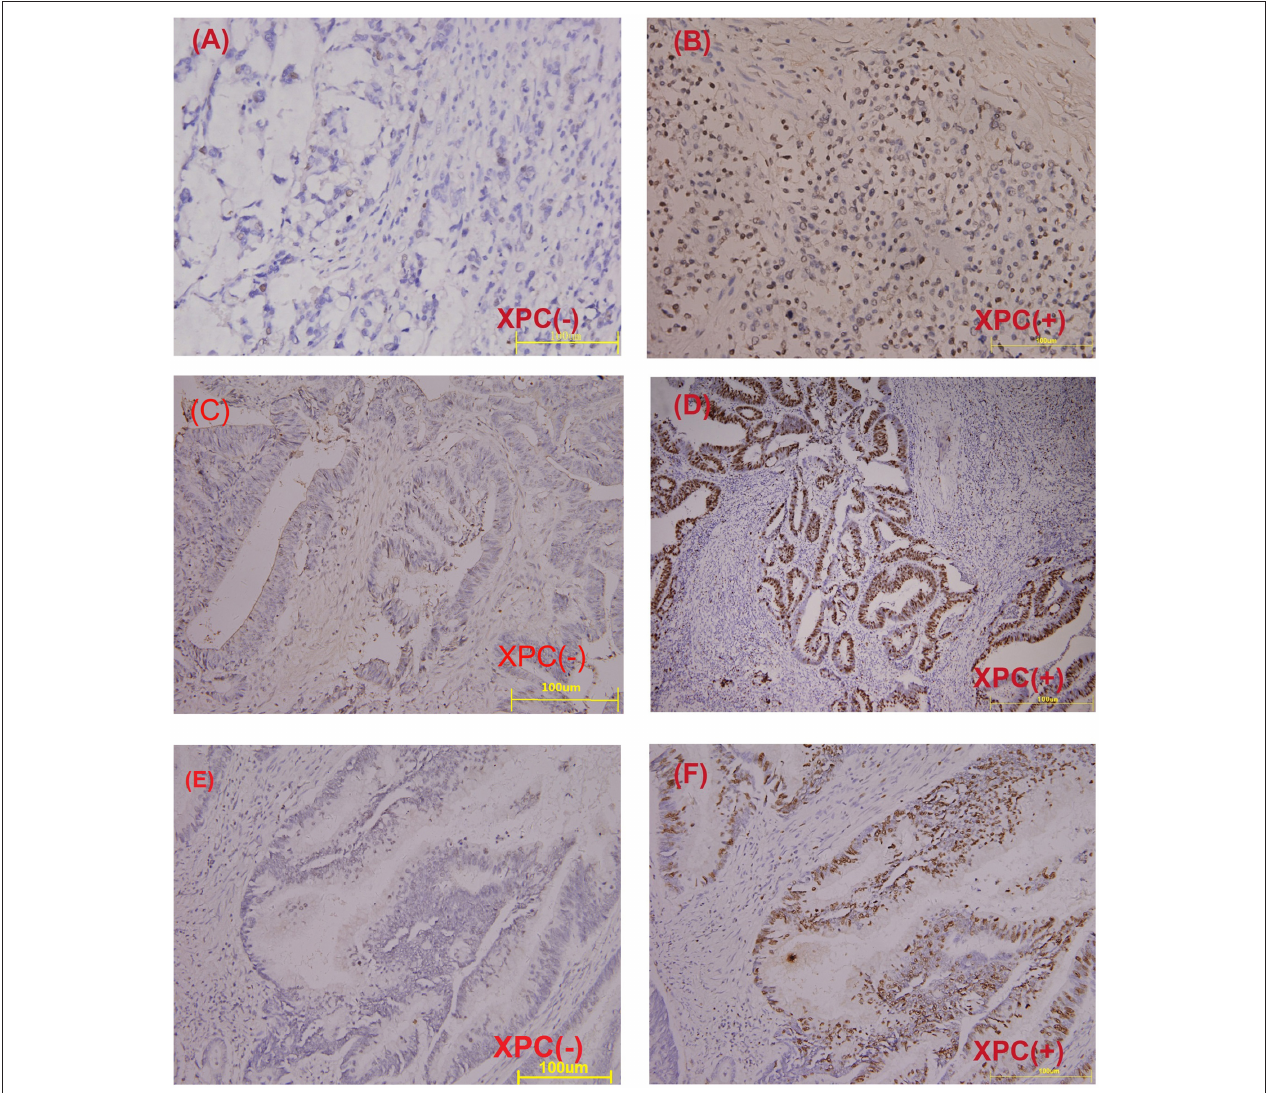
FIGURE 5 | Immunohistochemical staining of paraffin embedded colorectal carcinoma . (A) Negative XPC expression in poor differentiated carcinoma. (B) Positive XPC expression in poor differentiated carcinoma. (C) Negative XPC expression in moderately differentiated carcinoma. (D) Positive XPC expression in moderately differentiated carcinoma. (E) Negative XPC expression in well differentiated carcinoma. (F) Positive XPC expression in well differentiated carcinoma.